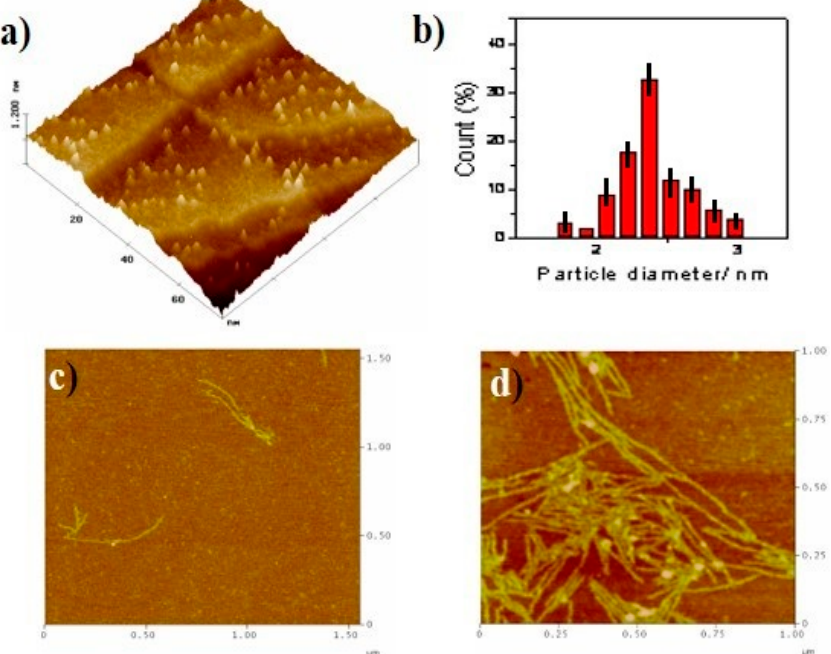
Figure 8. ( a ) 75 nm × 75 nm STM 3D image of the Au(111) surface after 1 min immersion into a G1 10 − 9 M water solution. ( b ) Particle size histogram of G1 . AFM image of mica surface after di ff erent times